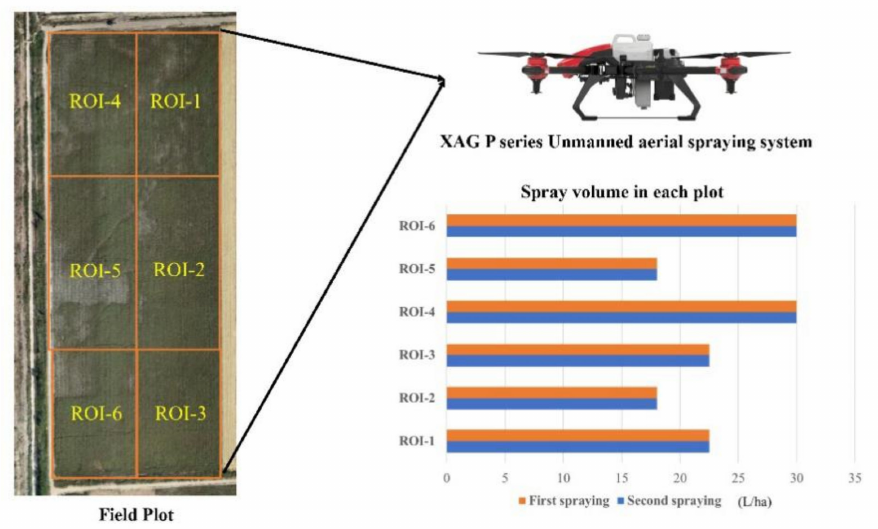
Figure 1. Schematic diagram of the test plot and spraying